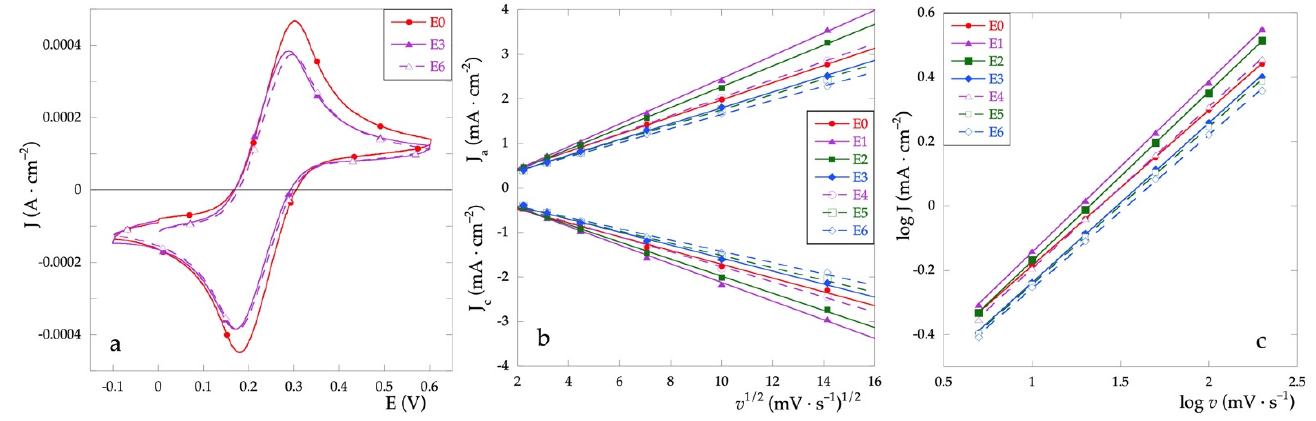
Figure 6. ( a ) CV curves recorded in Fe +2 /Fe +3 solution and v = 5 mV·s − 1 ; ( b ) dependence of J pa and J pc vs. v 1/2 at various scan rates; ( c ) log (J) vs. log ( v ) plot. Table 3. Electrochemical data from cyclic voltammetries with Fe +2 /Fe +3 at 5 mV · s − 1